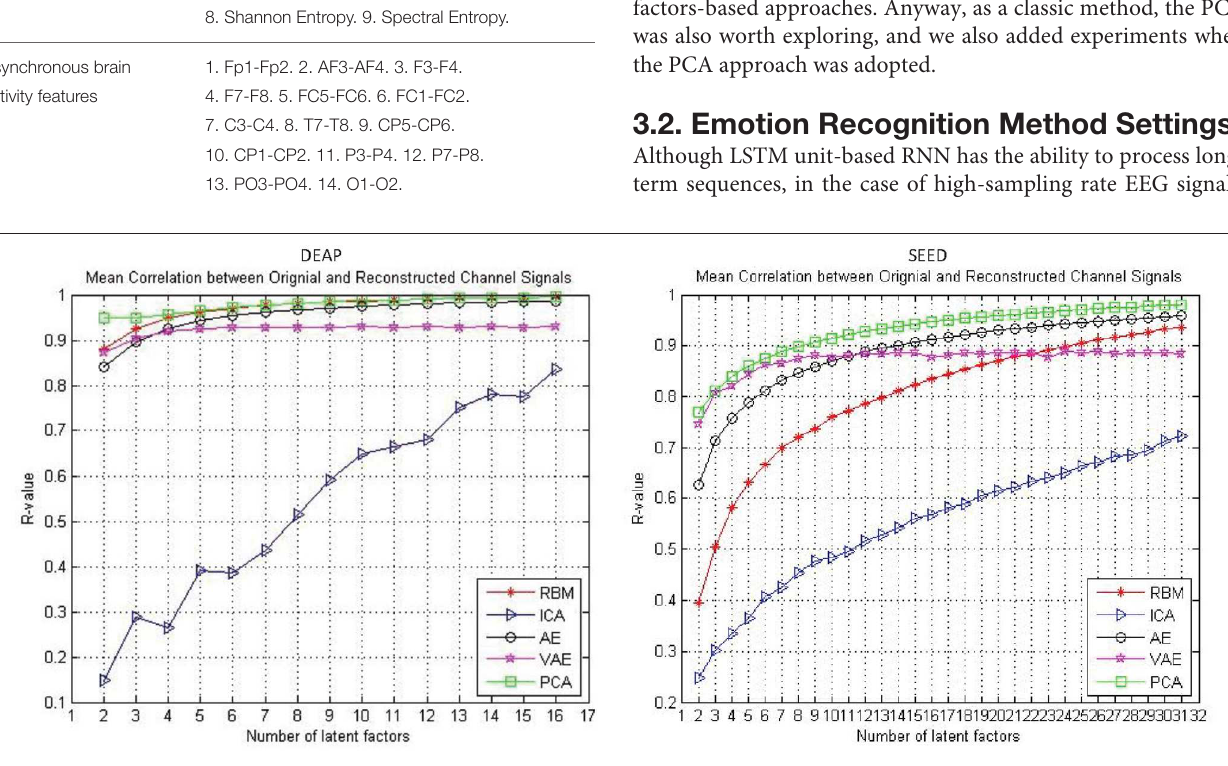
Frontiers in Neuroscience |